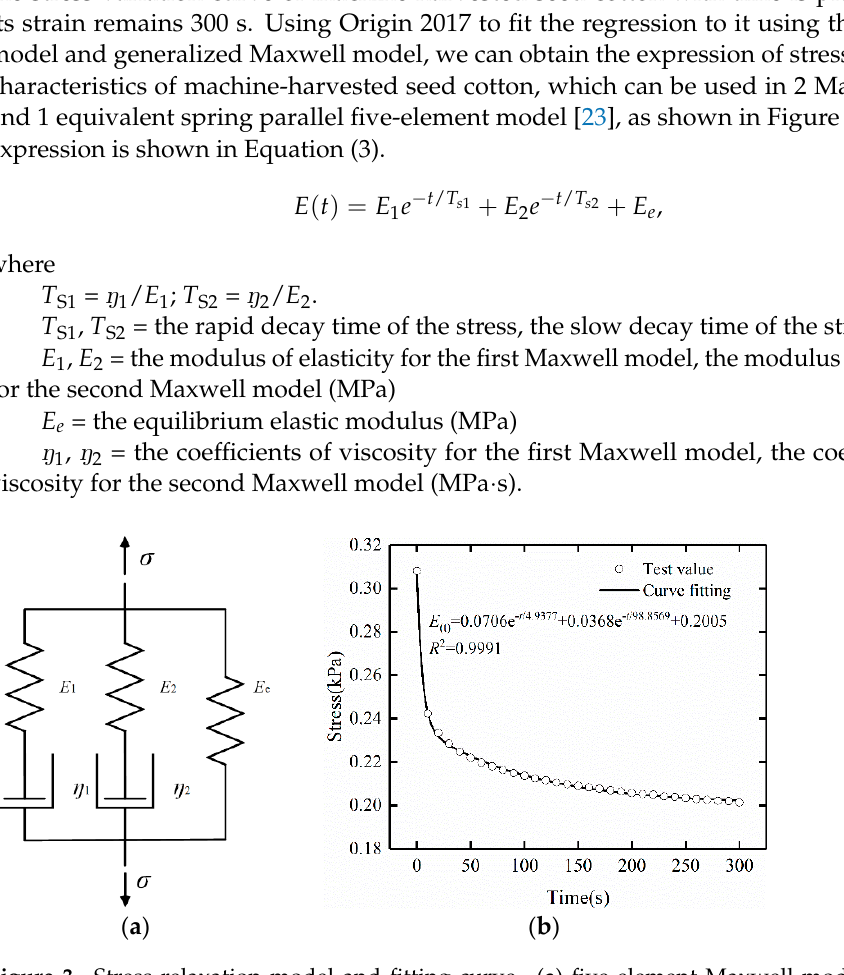
Figure 3. Stress relaxation model and fitting curve. ( a ) five-element Maxwell mode; ( b ) stress relaxation of machine-harvested cotton fitting curve.